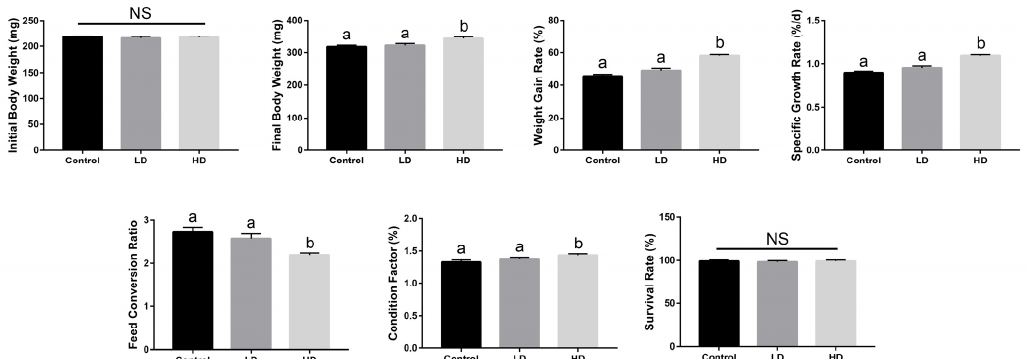
Figure 1. Effects of dietary Bacillus licheniformis FA6 on the growth performance of zebrafish. Data are presented as mean ± SD for three replicate groups, with 40 fish in each group. The means of different superscripts in the same row are significantly different. Different letters above the bars indicate significant differences at the 0.05 level (ANOVA and Duncan’s multiple range test), n = 3. “NS” indicates not significant ( p > 0.05).